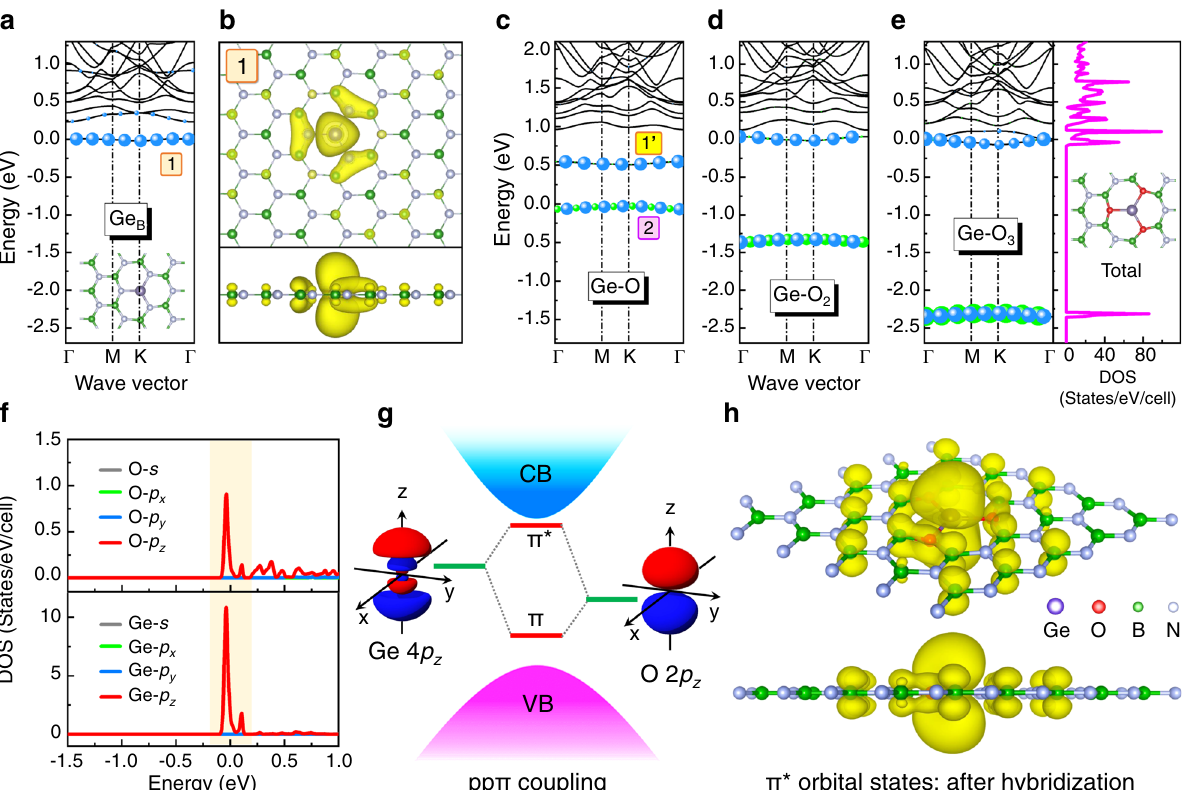
Fig. 1 Sacri fi cial impurity coupling induced orbital level engineering. a Energy band structure of h-BN:Ge B system. The blue dots represent the Ge- contributed electronic states. The inset shows the atomic structure of Ge doping in the h-BN monolayer. b Top view (top) and side view (bottom) charge contributions of the Ge impurity level 1 of h-BN:Ge B system. c Energy band structure of h-BN:Ge-O system. d Energy band structure of h-BN:Ge-O 2 system. e Energy band structure and total DOSs of h-BN:Ge-O 3 system. The blue and green dots represent the Ge- and O-contributed electronic states, respectively. The inset in total DOSs shows the atomic structure of h-BN:Ge-O 3 . f Partial DOSs from the Ge and O atoms of h-BN:Ge-O 3 system. g Schematic of the orbital split induced level engineering through the pp π coupling between the Ge 4 p z and O 2 p z orbitals. h Top view (top) and side view (bottom) charge contributions of the impurity level 1 ’ of h-BN:Ge-O 3